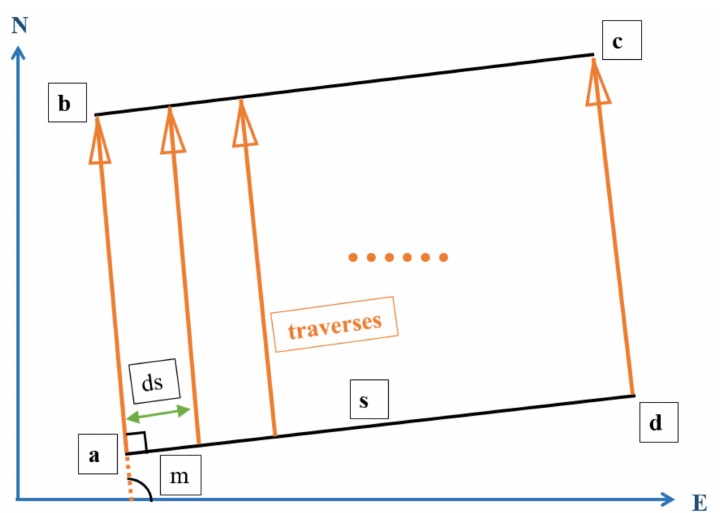
Figure 4. Illustration of GPR traverse survey